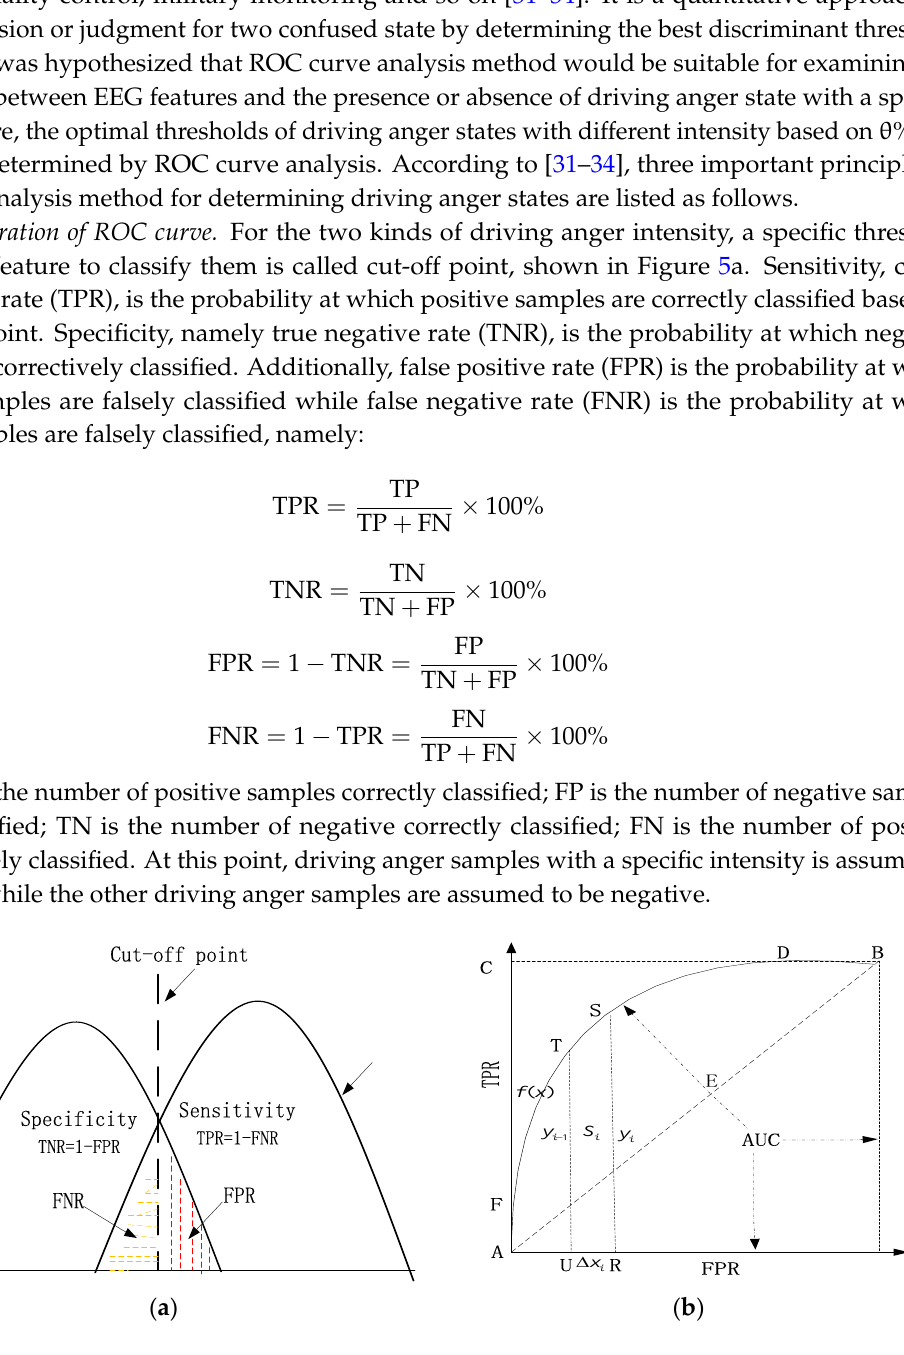
Figure 5. Schematic of ROC curve system. ( a ) Cut-off points to form ROC curve; ( b ) FPR, TPR and AUC in coordinate system.